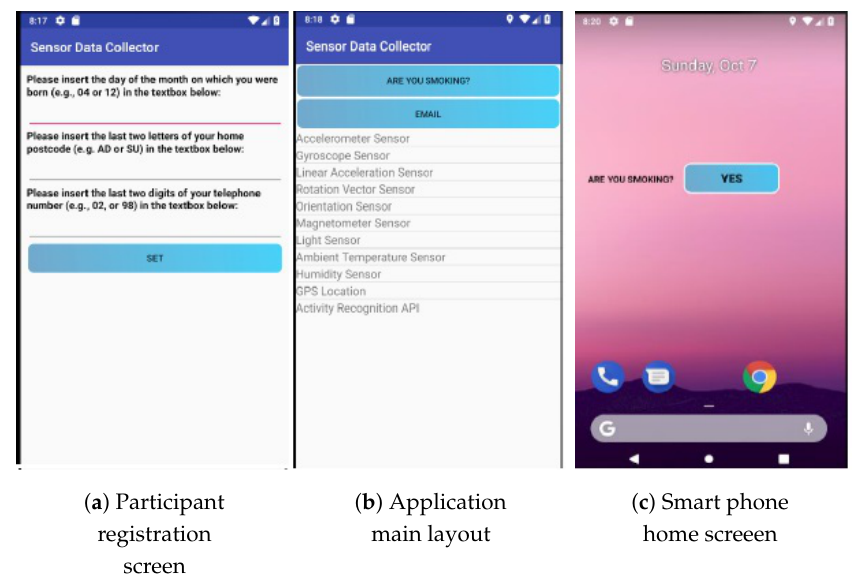
Figure 5. Mobile application User Interface (UI)